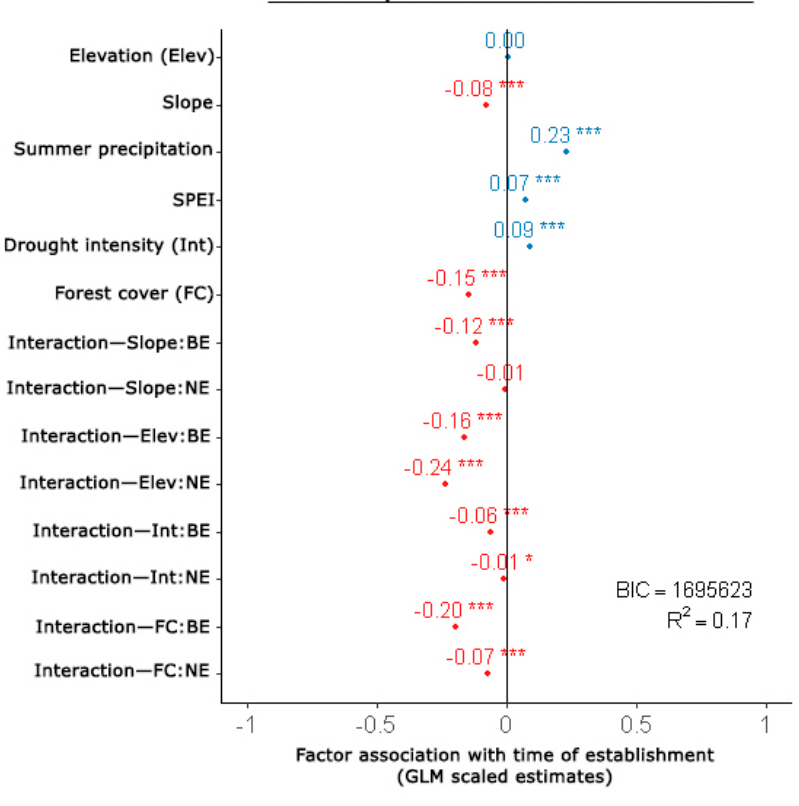
Figure 3. General linear model (GLM) parameter estimates of the relationships between the time (quinquennium) of secondary forest establishment and elevation (m), slope ( ◦ ), annual precipitation (mm), mean annual SPEI values, drought intensity, forest cover in a 1 km radius (%) and interaction with secondary forest leaf-habit broadleaf evergreen (BE) and needleleaf evergreen (NE) forests compared to broadleaf deciduous (BD) forests. Climatic values were calculated from the mean of the period 1950–2015. Significance is indicated using the following p -values: *: 0.05, ***: 0.001.